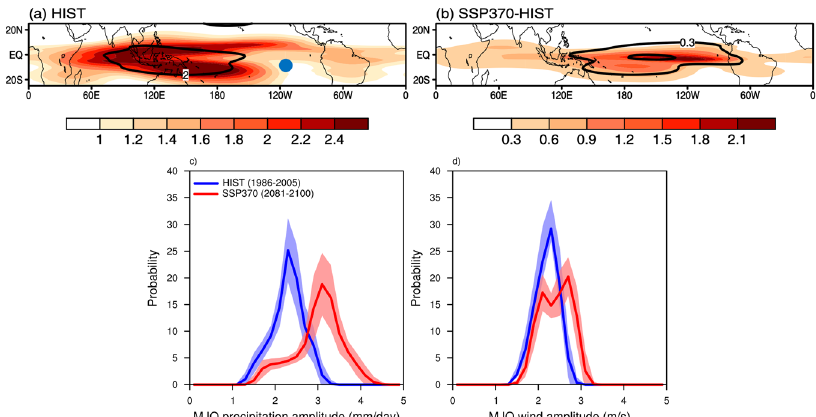
Fig. 1 Absolute responses of MJO precipitation and wind amplitude to global warming. a , b Spatial distribution of the standard deviation of 20 – 100 days and eastward wavenumber 1 – 5 fi ltered precipitation (shaded, units are mm/day) and 850 hPa zonal wind (contour, units are m/s) for a historical simulation (1986 – 2005) and b difference between SSP370 (2081 – 2100) and historical simulations. c , d Probability distribution of c MJO precipitation amplitude (units are %/mm/day) and d MJO wind amplitude (units are %/m/s) averaged over the domain of 15°S-Eq., 60°E-180° for the historical (blue) and SSP370 (red) simulations. The light blue and red shadings in c , d represent ±1 standard deviation calculated across the 100 ensemble members relative to the ensemble mean. The small blue dot in a is the sample grid cell (5°S, 110°W) used to estimate time of emergence of MJO changes in Fig.